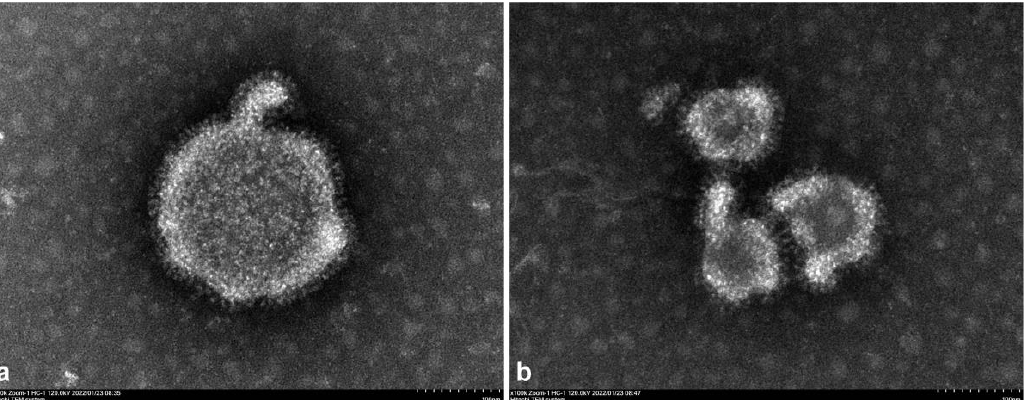
Figure 3. Transmission electron microscopy observation of the virus. ( a ) XJ21032-1 isolate. ( b ) XJ20055-3 isolate.